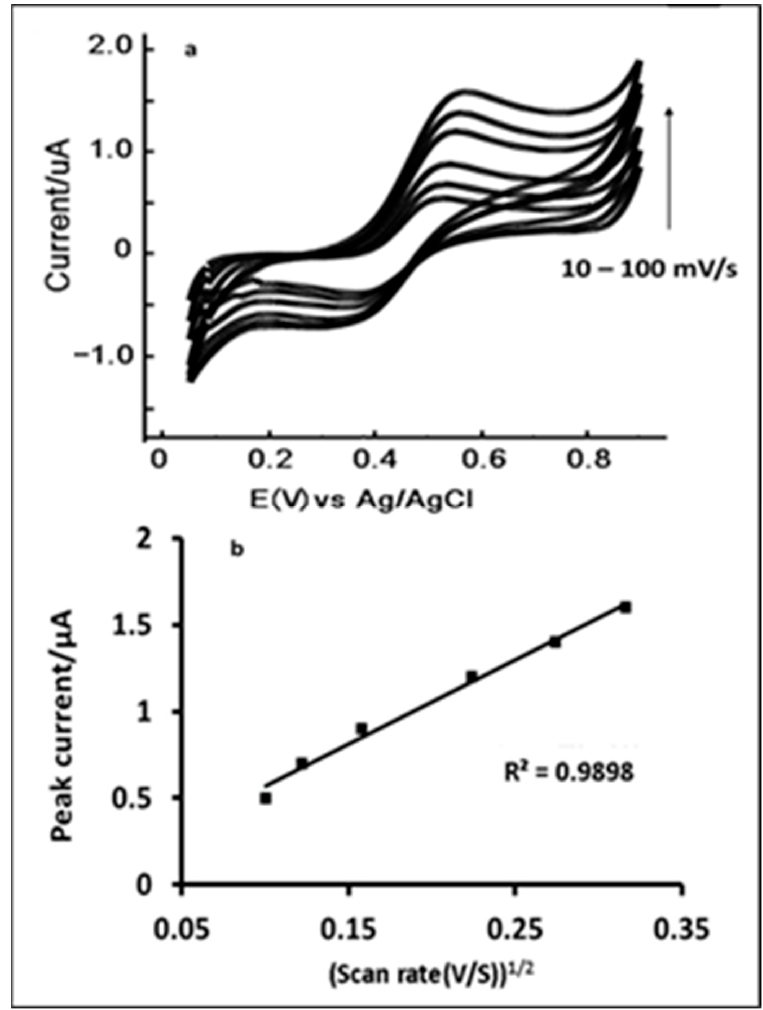
Figure 4. ( a ) CVs of 100 µ M DIC + via water|1,6-DCH microinterface at increasing potential scan rates of 10 to 100 mV s − 1 , as indicated by the arrow. ( b ) Peak currents versus the square root of the scan rate on the forward and reverse sweeps .